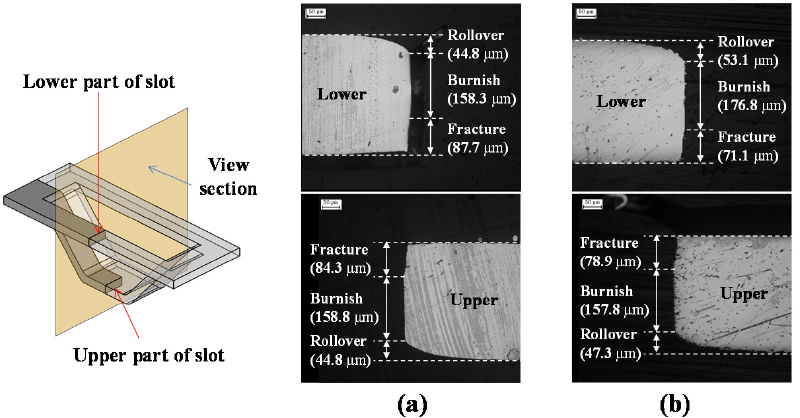
Figure 4. Cross-section shapes of slots and lengths in slitting plane with different forming heights: ( a ) 1.63 and ( b ) 1.97 mm.